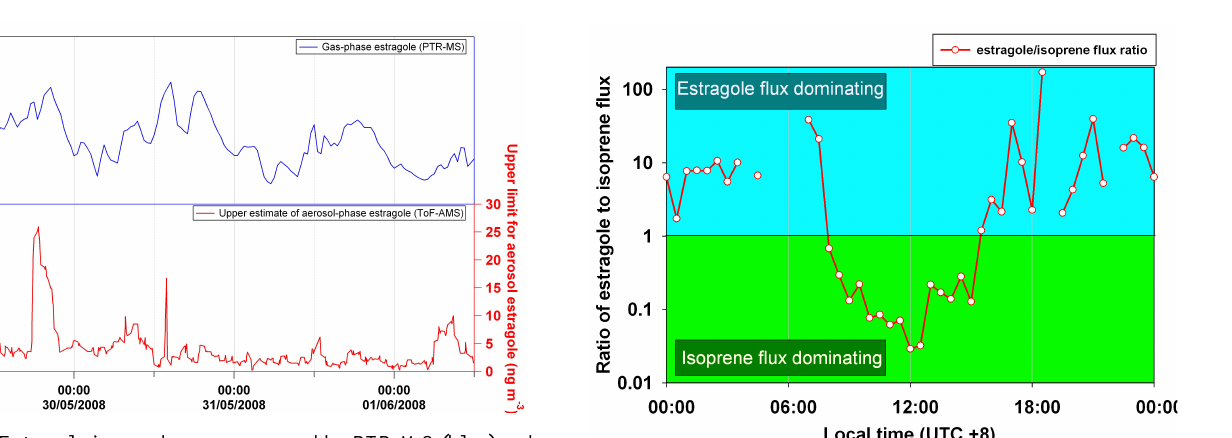
Fig. 7. Estragole in gas phase as measured by PTR-MS (blue) and upper limit in the aerosol phase (measured by AMS) as estimated from typical fragmentation patterns for estragole. Fig. 8. Diurnal trend of the ratios of estragole to isoprene flux, showing the morning and afternoon times when estragole flux dom- inated over the isoprene flux, which was very high during the day. The fluxes of these two compounds had similar values at around 08:00 and 15:30h local time